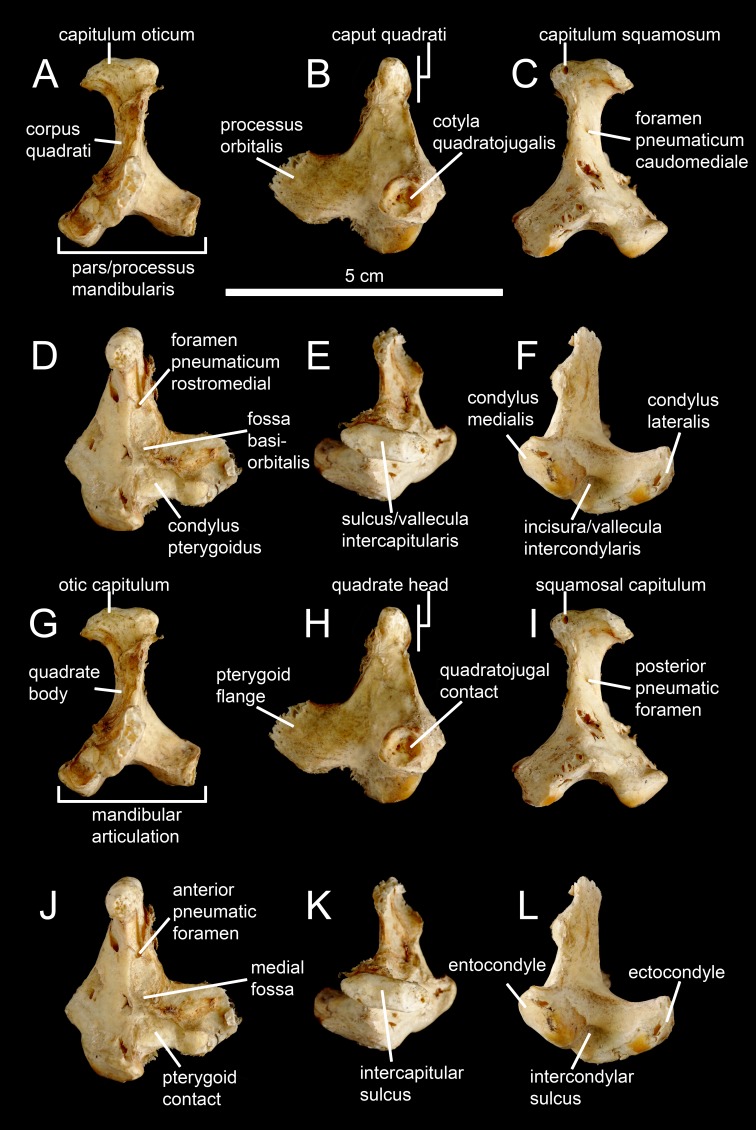
Avian and non-avian theropod terminology of the quadrate bone.Left quadrate of the common ostrich Struthio camelus (NH.11.75; courtesy of Paolo Viscardi) in (A, G) anterior, (B, H) lateral, (C, I) posterior, (D, J) medial, (E, K) dorsal, and (F, L) ventral views. The ostrich quadrate is annotated with (A–F) Baumel & Witmer (1993), Elzanowski, Paul & Stidham (2001) and Elzanowski & Stidham’s (2010) terminologies, and (G–L) the here proposed terminology for the non-avian theropod quadrate.